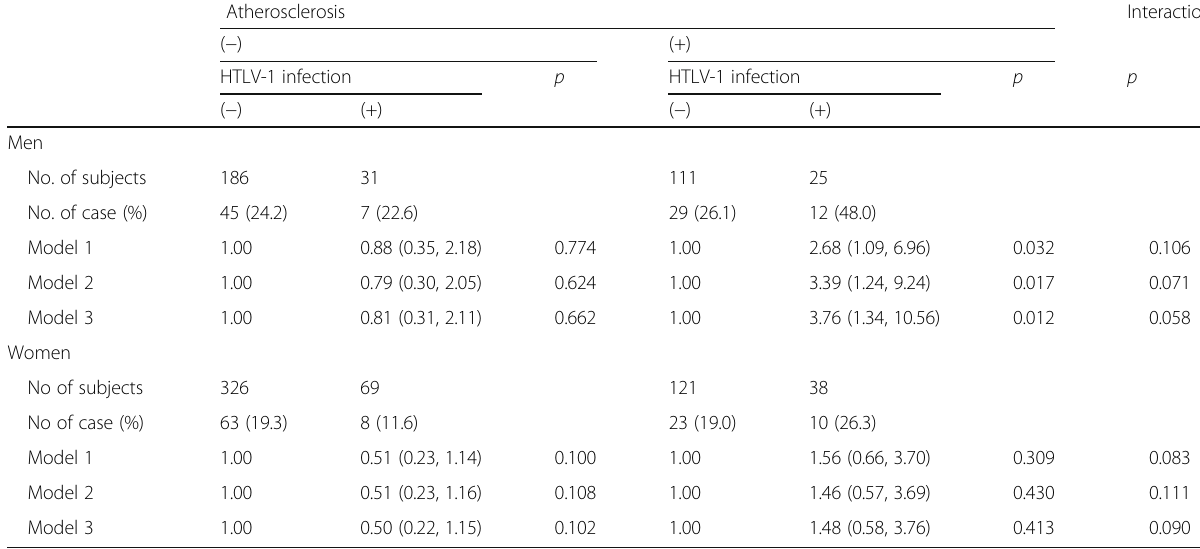
Table 5 Sex-specific odds ratios (OR) and 95% confidence intervals (CIs) for advanced periodontitis in relation to human T cell leukemia virus-1 (HTLV-1) infections by status of atherosclerosis Atherosclerosis